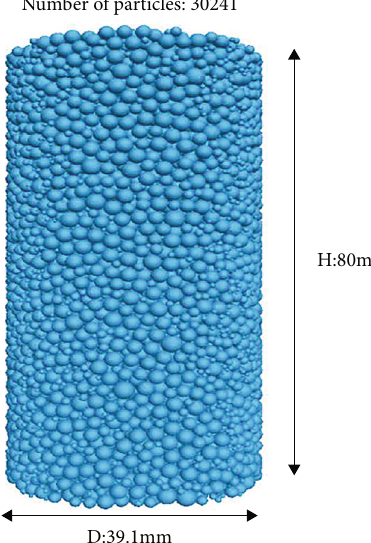
Figure 3: Numerical model of triaxial test.